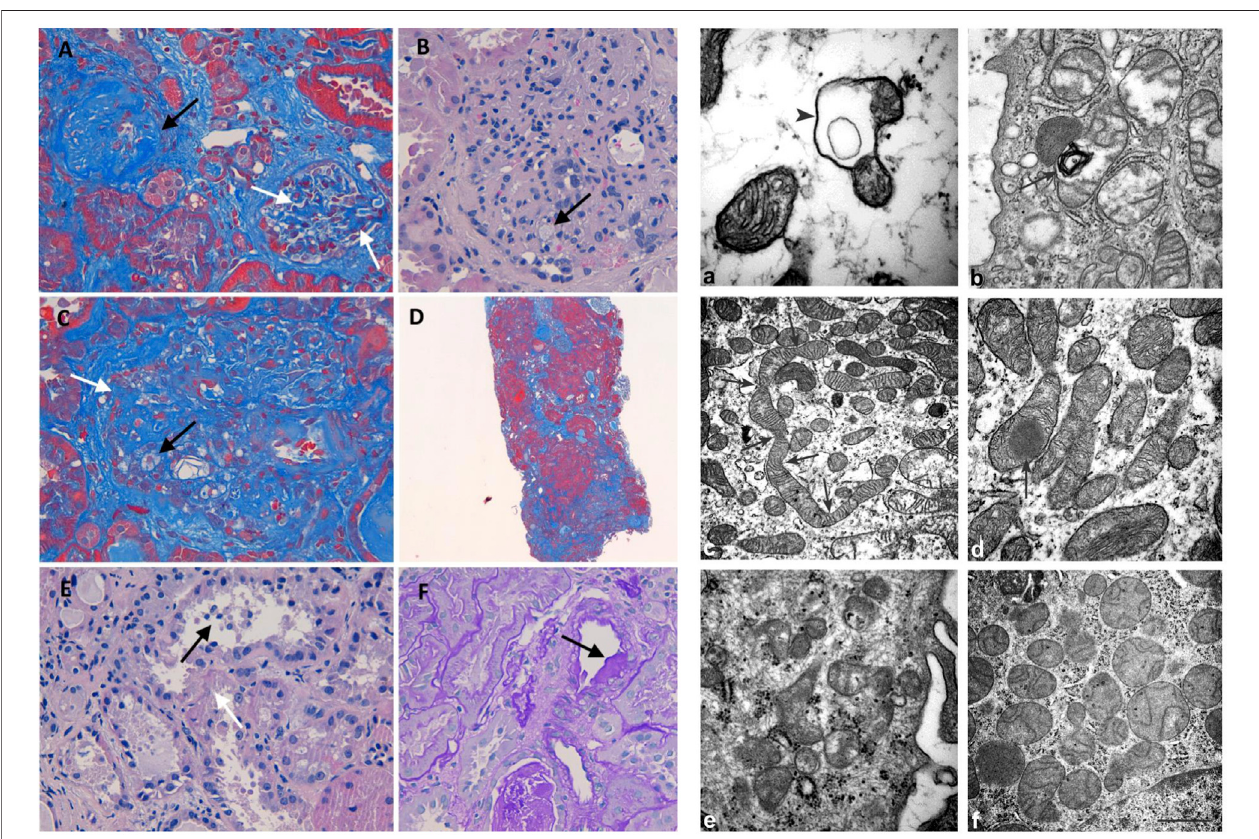
FIGURE2| Histologyandelectron microscopy.Masson ’ strichrome (200x):global(black arrow)and segmental (whitearrows) glomerulosclerosis (A) . H&E(400x): glomerulus with mesangial matrix expansion, mesangial hypercellularity, capillary loops adherent to Bowman capsule, and foam cells (black arrow) (B) . Masson ’ s trichrome(400x):foamcells(blackarrow)andsegmental(whitearrows)sclerosis (C) .Masson ’ strichrome(400x):diffuseinterstitial fi brosis (D) .H&E(400x):lossofapical cytoplasm, necrosis of individual cells, detachment of epithelial cells in tubular lumen (black arrow), denudation of the tubular basement membrane (white arrow) (E) .PAS(400X):hyalinosisinasmallartery(blackarrow) (F) .Mitochondrionwithacyst-likestructure(arrowhead)in (a) andamyelin fi gure(arrow)in (b) .In (c) ,thearrows represent the narrowing of a long mitochondrion and in (D) an electron-dense inclusion within a mitochondrion. The kidney of control: normal mitochondria contained